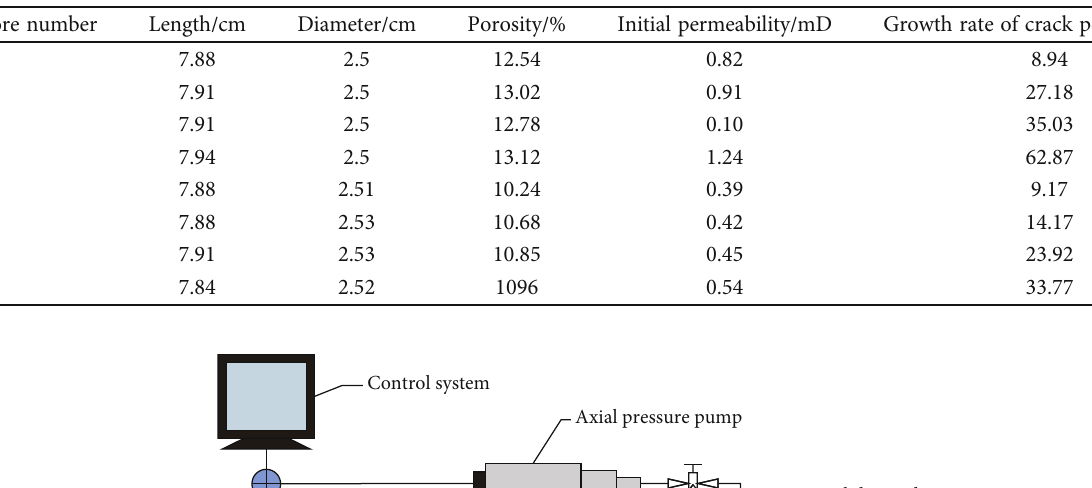
Table 1: Basic properties of cores.